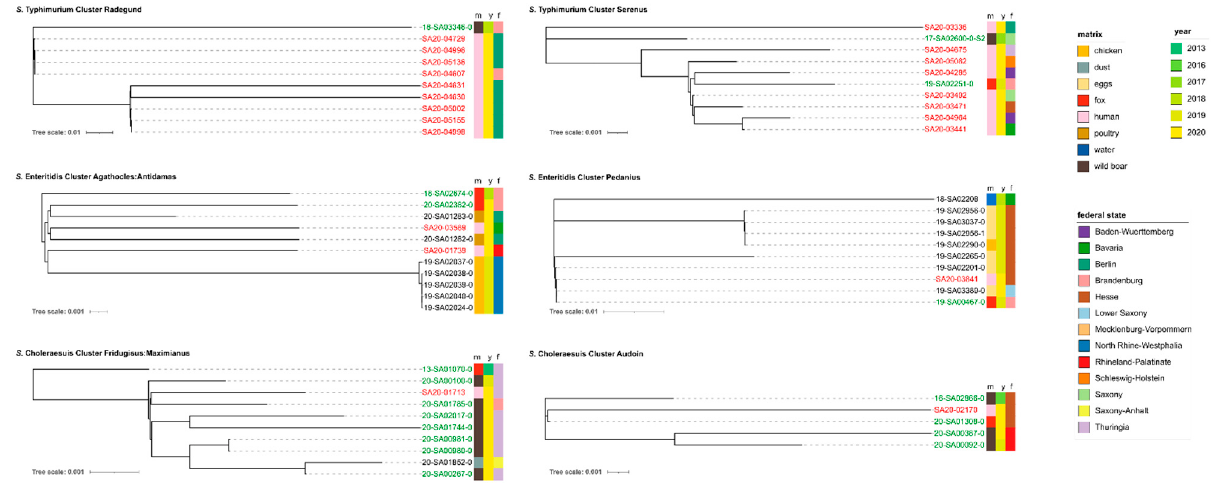
Figure 6. Phylogenetic trees of mixed-matrices clusters for the serovars S. Typhimurium (ST19), S. Enteritidis (ST11) and S. Choleraesuis (ST145). Maximum-likelihood phylogenetic tree based on core SNPs in the bacterial chromosome. The chromosome sequences of S. Typhimurium strain 16A242 (NZ_CP020922.1), S. Enteritidis strain ATCC BAA-708 (NZ_CP025554.1) and S. Choleraesuis strain SCSA50 isolate A50 (NZ_CM001062.1) were used as references. The trees were computed with the snippySnake pipeline with IQ-TREE, visualized in iTOL and manually rooted to the reference. The colour bars (left to right) identify the matrix (m), sampling year (y) and German federal state (f) from which the samples were obtained. Human clinical isolates are highlighted in red; wildlife isolates are highlighted in green. The scale bars show the genomic distances of the sequences in substitutions per site.